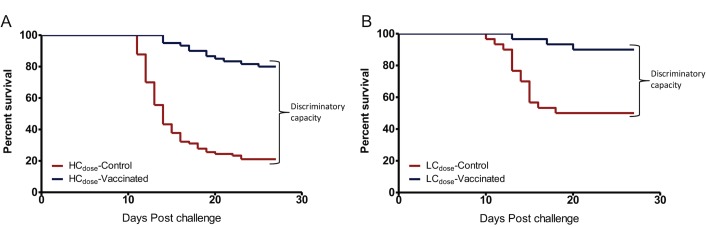
High and low virus challenge dose.Kaplan Meyer’s (KM) survival analysis of Atlantic salmon challenged using a high and low challenge dose carried out using strain NVI015-TA (Study II). (A) KM survival analysis for the high challenge dose (HCdose), 1x107 TCID50/fish. (B) KM survival analysis for the low challenge dose (LCdose), 1x105 TCID50/fish. Fig 1A shows a wider discriminatory capacity (DC>58%) compared to Fig 1B (DC = 40%) between the vaccinated and unvaccinated control fish.